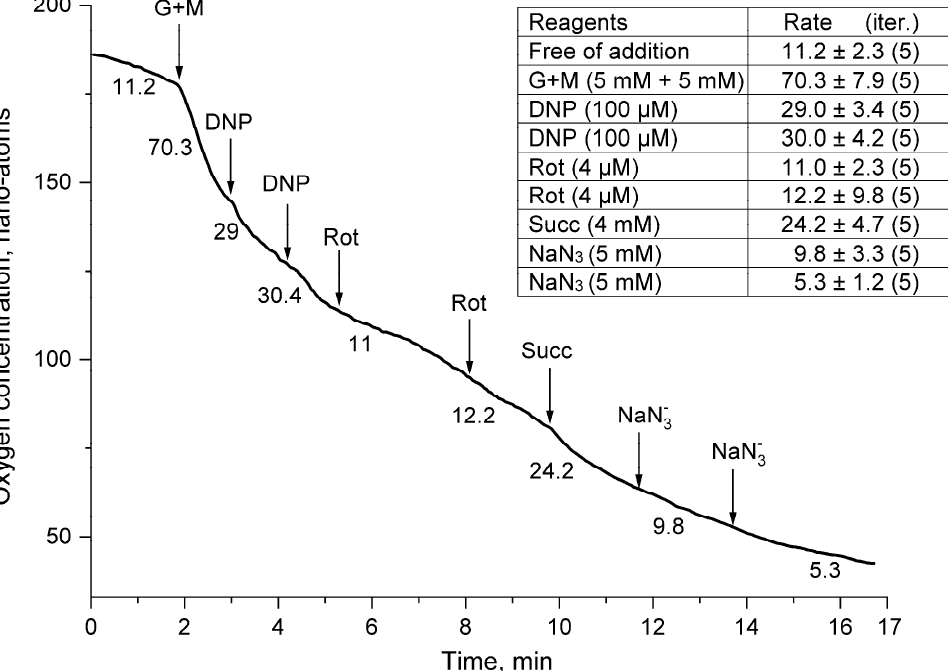
Figure 2. Oxygen uptake rates by thornback ray erythrocyte suspension. Erythrocytes (25–30% hematocrit) were added to a medium containing 220 mM NaCl, 300 mM urea, and 5 mM Tris-HCl (pH 7.4). Arrows, respectively, indicate additions of reagents to the concentrations in the medium: 5 mM tris-glutamate and 5 mM tris-malate (G + M), 100 µM 2,4-dinitrophenol (DNP), 4 µM rotenone (Rot), 5 mM tris-succinate (Succ), and 5 mM NaN 3 (N 3 − ). The numbers above the curves indicate the rates of oxygen uptake by erythrocytes (pmol O 2 /min·10 6 cells).